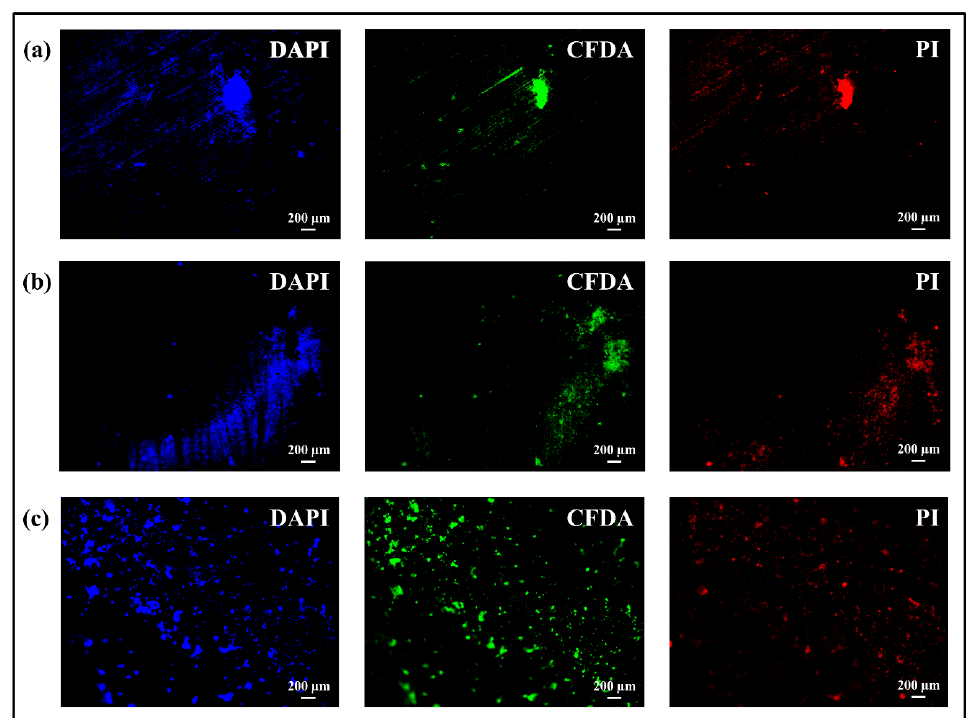
Figure 10. Fluorescence micrographs after PI, CFDA, and DAPI staining of S. epidermidis exposed for 12 h to: ( a ) Ti-alloy, ( b ) CS / PEO and ( c ) CS / PEO / BG. Live and dead cells are labeled with green and red stains, respectively, whereas nuclei display in blue color. Images were obtained at a 4X magnification.